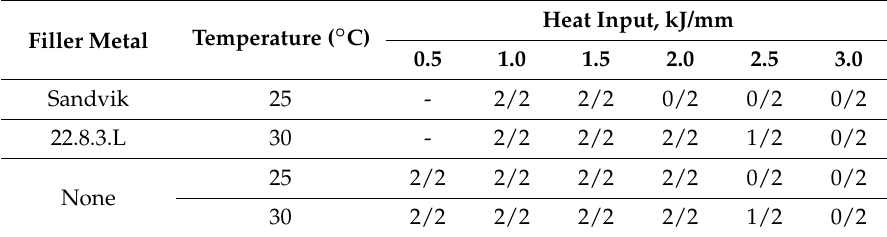
Table 2. Pitting tests on TIG-welded bead-on-tube welds of 2205 X/2 = Specimens attacked/specimens tested solution: 10% FeCl 3 · 6H 2